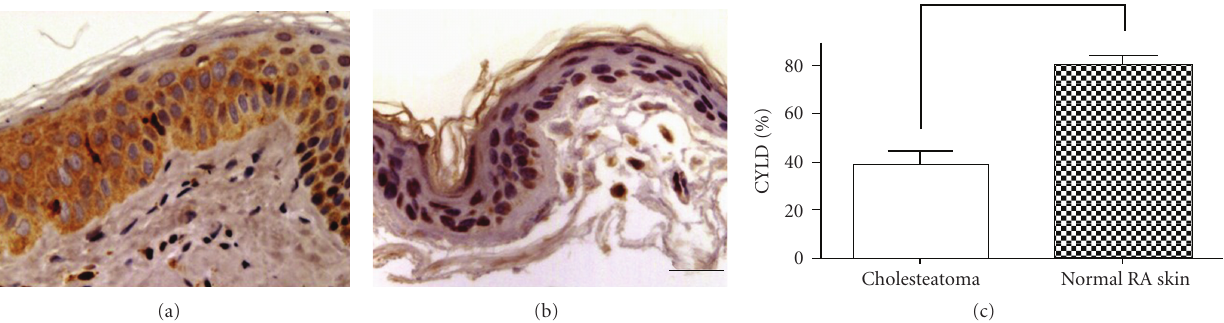
Figure 1: Immunohistochemistry of CYLD in cholesteatoma epithelium and normal retroauricular (RA) skin. (a): CYLD in normal RA skin. (b): CYLD in cholesteatoma epithelium. Note that strong CYLD immunoreactivity was observed mainly in the cytoplasm of cells in the basal and suprabasal epithelial layers of normal RA skin, whereas weak expression was detected in the cytoplasm of cells in the basal layer of the cholesteatoma epithelium. Bar = 300 μ m. (c): Rates of positive labeling for CYLD in cholesteatoma epithelium and normal RA skin. The rate of cells positive for CYLD was significantly lower in cholesteatoma epithelium than in normal RA skin. Data are presented as means ± SD. ∗ P < .